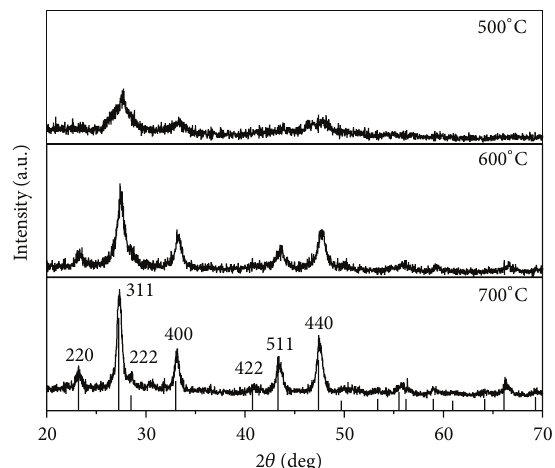
Figure 1: XRD patterns of CdIn 2 S 4 prepared at different tempera-